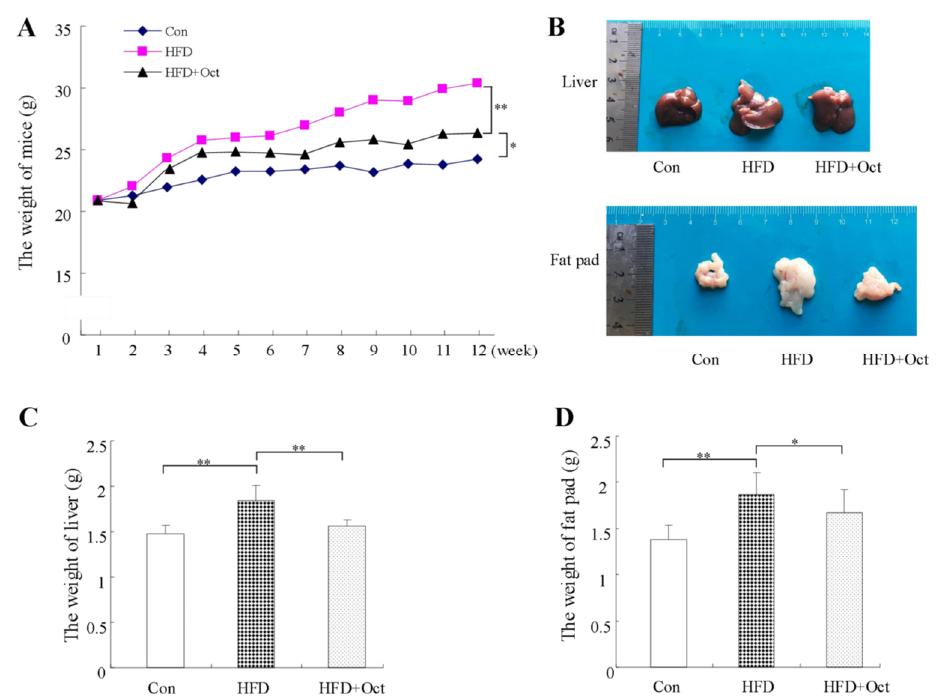
Figure 2. Effects of octacosanol on HFD-induced mice bodyweight gain. Thirty 8-week-old C57BL/6J mice were randomized into three groups (10 per group), and the mice from the Control, HFD, and HFD+Oct group were fed for 10 weeks. ( A ) Bodyweight change of mice during 10 weeks. ( B ) Representative image of liver and fat pad of mice at the end of feeding; ( C ) effect of octacosanol on the live weight at the end of feeding; ( D ) effect of octacosanol on the weight of retroperitoneal fat pads at the end of feeding. Data presented as mean ± SD, n = 10. Oct, octacosanol; HFD, high-fat diet; **: p < 0.01; *: p < 0.05.